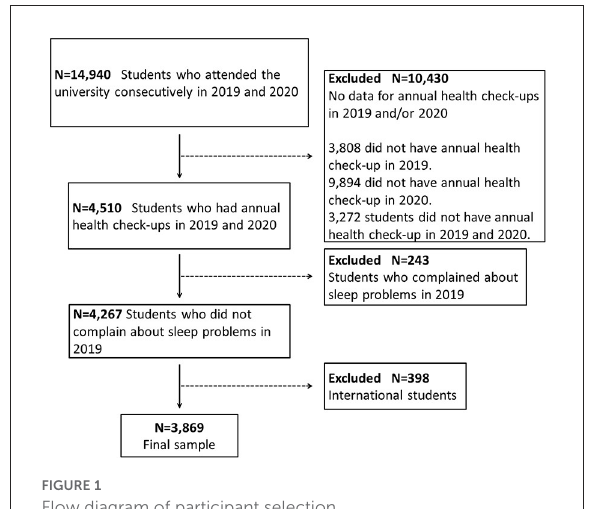
FIGURE1 Flow diagram of participant